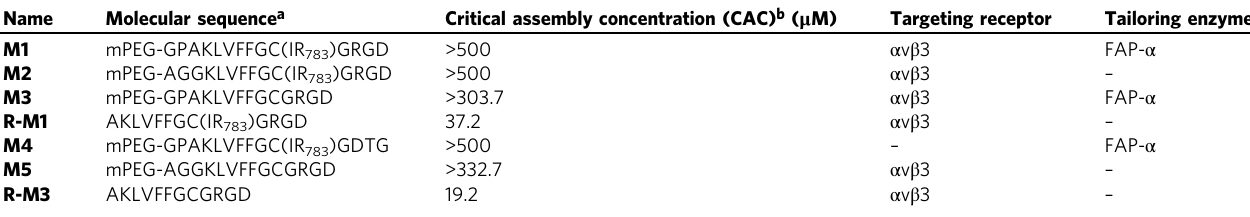
Table 1 The sequence, assembled behavior, targeting and tailoring capability of different designed molecules.